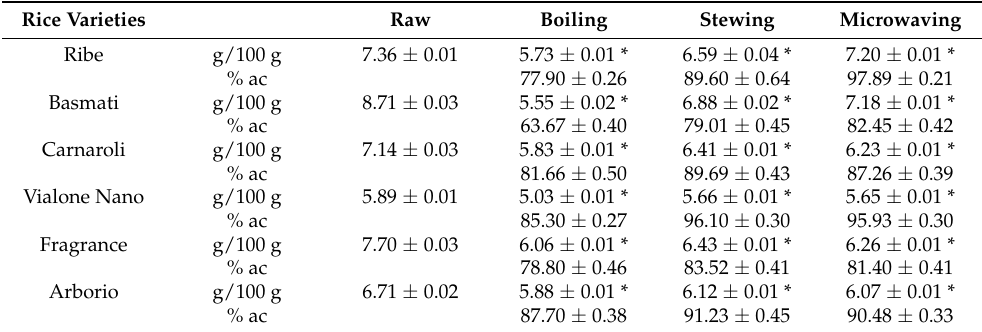
Table 3. Detectable protein content (g/100 g of rice) of both raw and cooked rice and percentage of retained proteins after the three cooking methods processes.